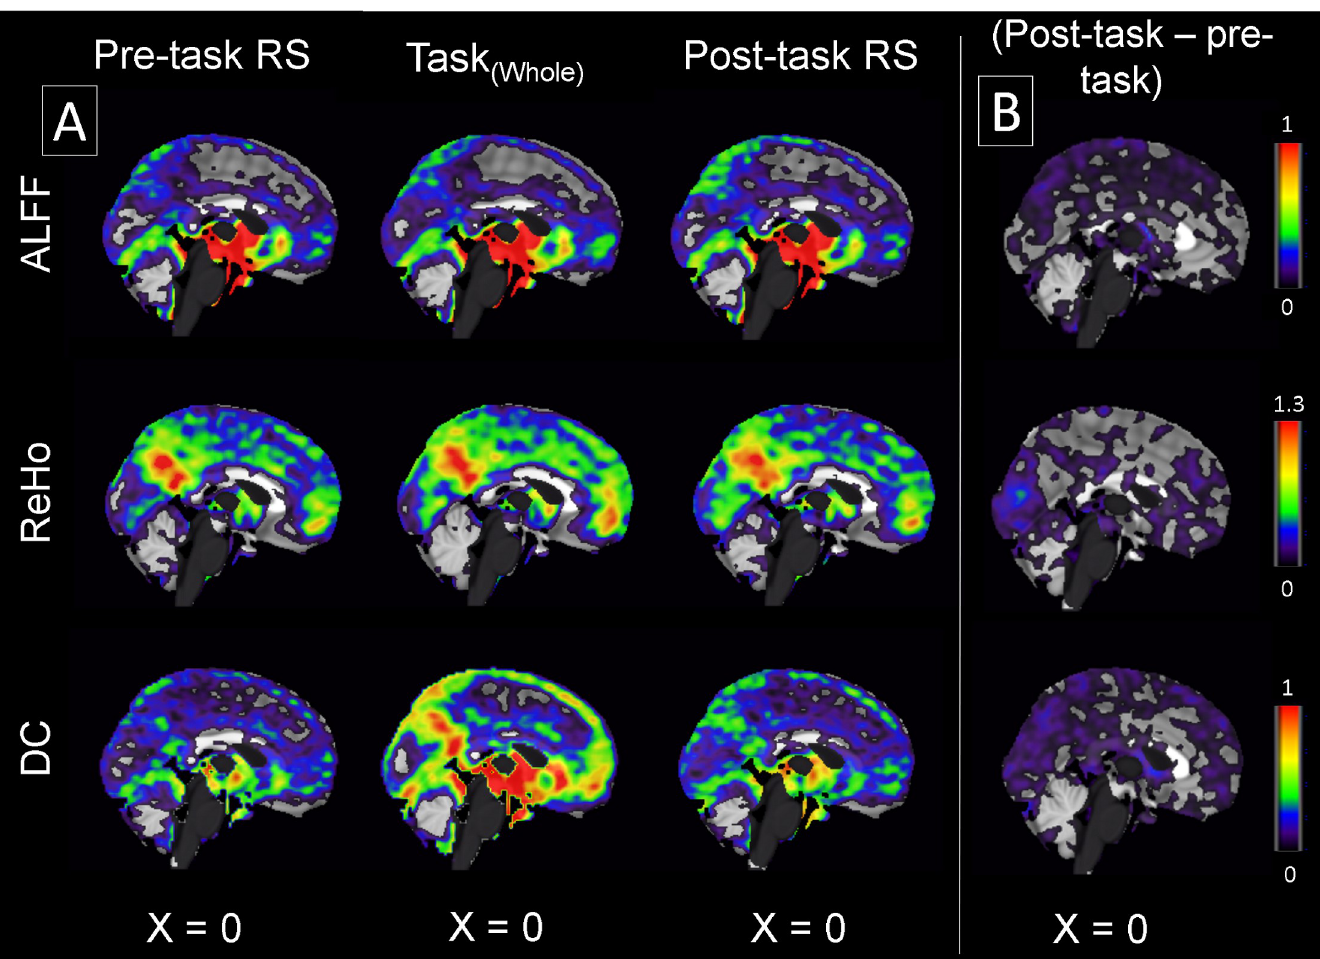
Fig 3. fMRI measures (ALFF, ReHo, and DC) from 21 subjects depicted for the whole brain. The difference between the two resting states (R2-R1) for each three fMRI measures is shown in the right row